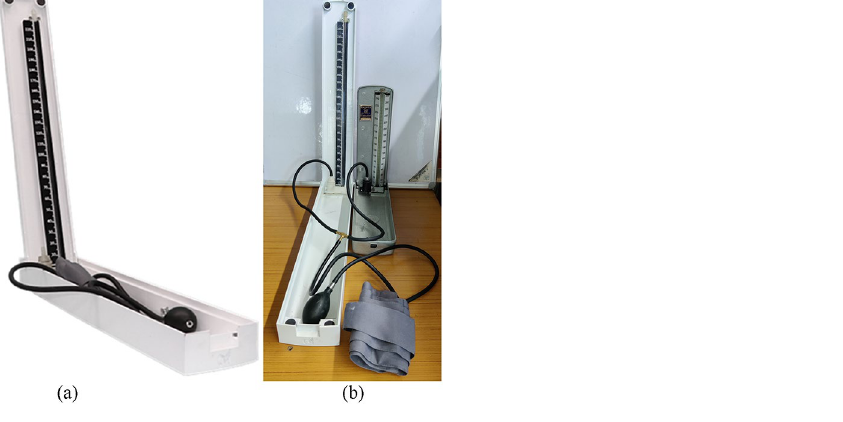
Figure 3. ( a ) Complete alpha-prototype of Merkfree, ( b ) technical comparison of Merkfree asainst MS through a T-connector